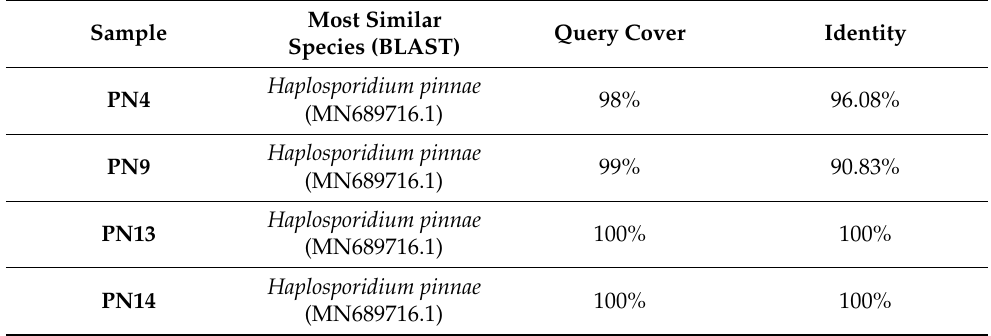
Table 3. NCBI high-similarity blast analysis for Sanger sequences obtained from Pinna nobilis by Haplosporidium sp.-positive samples from PCR.